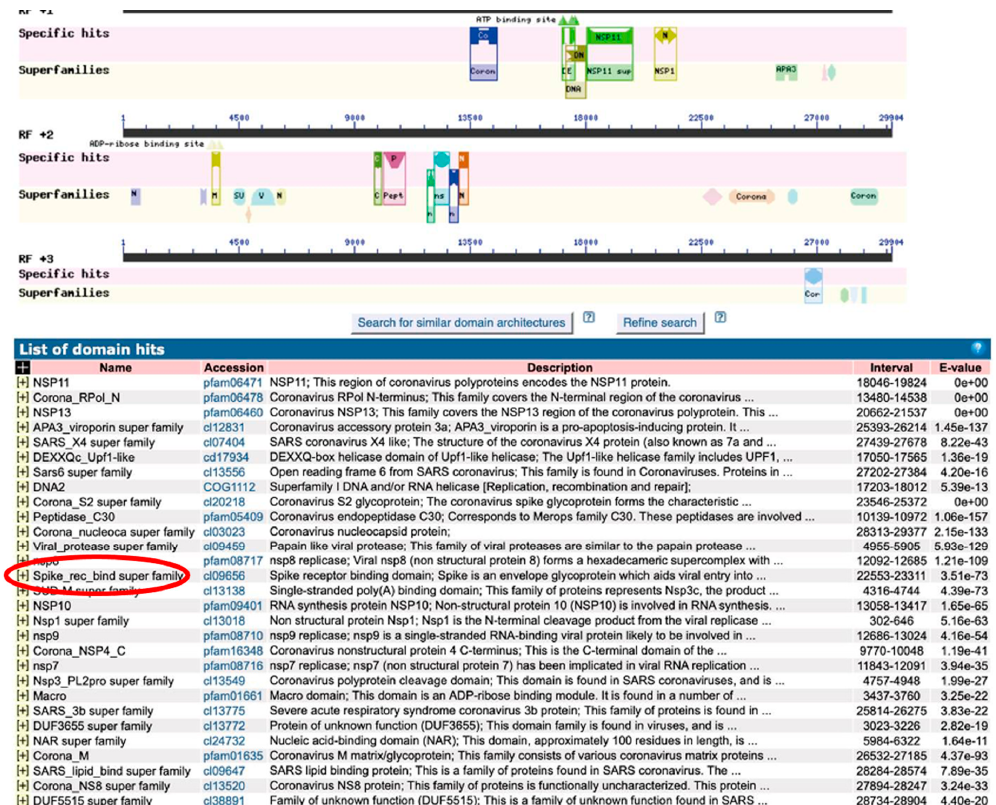
Figure 2. Severe acute respiratory syndrome coronavirus 2 ( SARS-CoV-2) domain search. Results Figure2. Severeacuterespiratorysyndromecoronavirus2 (SARS-CoV-2)domainsearch.